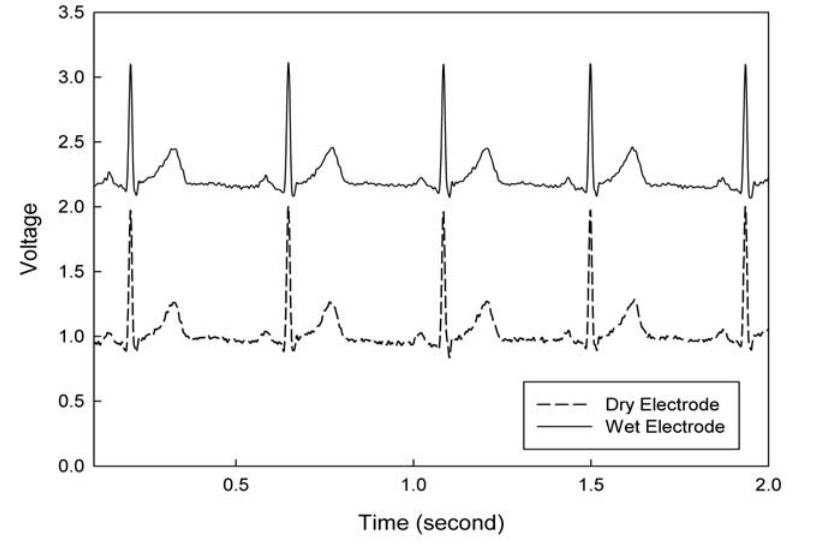
Figure 12. ECG signals sensed by the proposed bio-potential acquisition circuits.